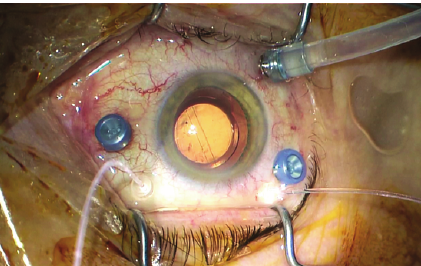
Figure 1: Hybrid 25-27-gauge vitrectomy setting following coaxial